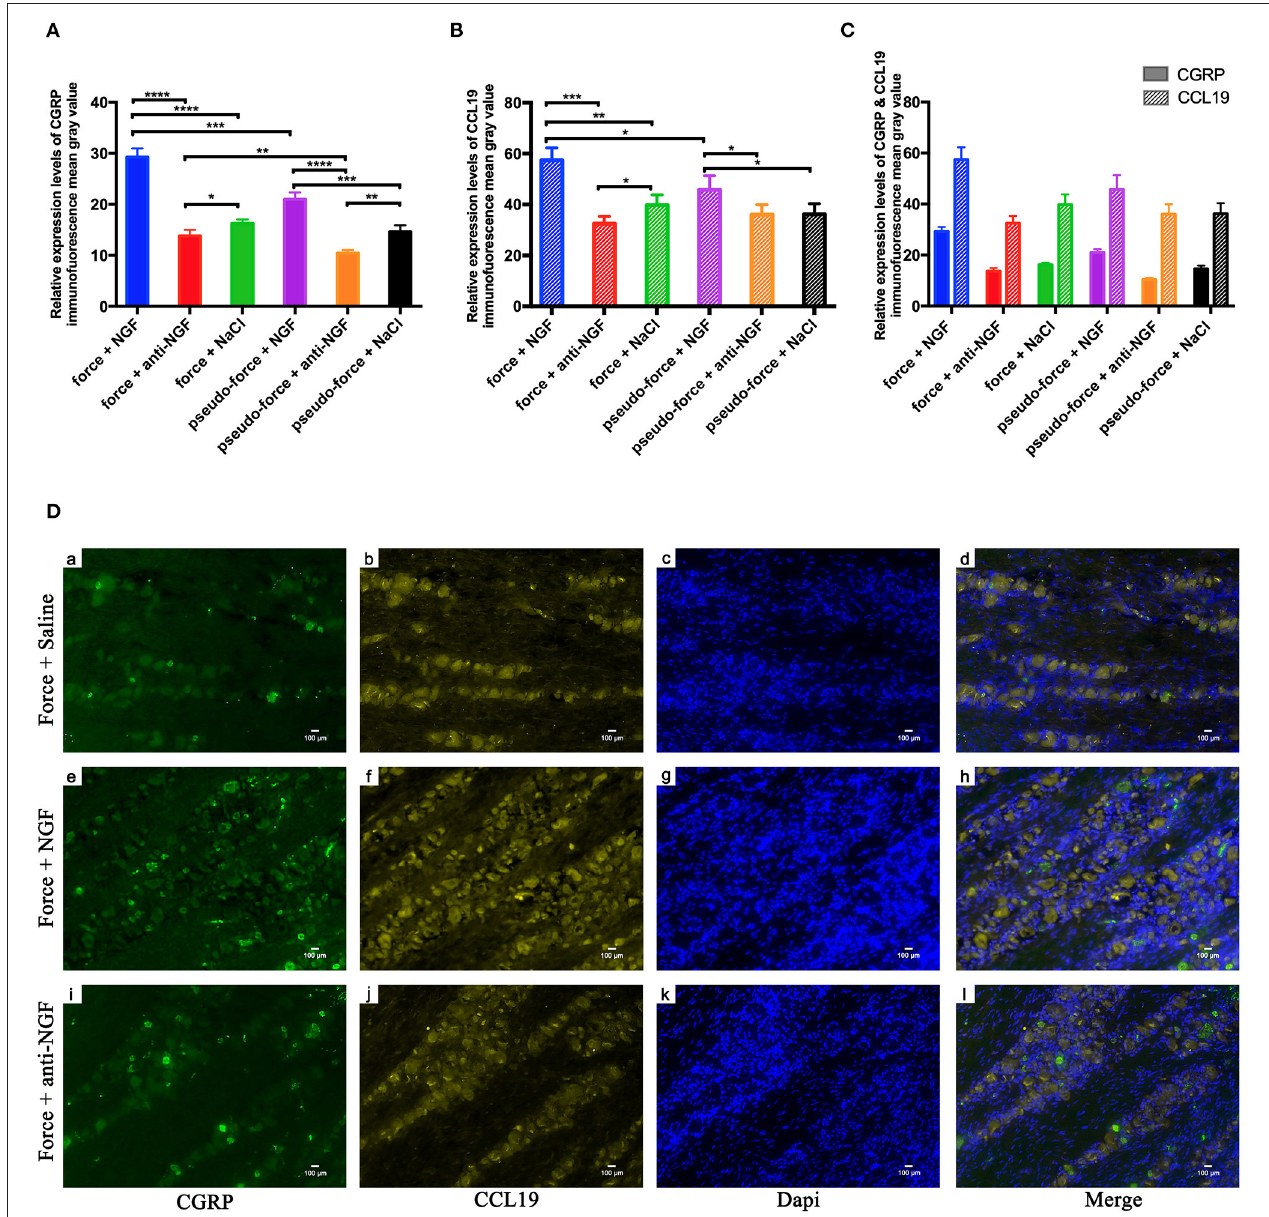
FIGURE 3 | ( A ) Calcitonin gene-related peptide (CGRP) protein expression levels in TGs following different interventions after experimental tooth movement. ( B ) CCL19 protein expression levels in TGs following different interventions after experimental tooth movement. ( C ) Comparison of immunofluorescence mean gray value of CGRP and CCL19 relative expression. ( D ) Immunofluorescence results of protein expression after injection on NGF, anti-NGF antibody, and normal saline into forced rats’ TGs on the 3rd day after tooth movement. ( a, e, i ) Neurons expressing CGRP (green) after injection of related reagents. ( b, f, j ) Neurons expressing CCL19 (yellow). ( c, g, k ) Nuclei (blue) after injection of related reagents on day 3. ( d, h, l ) Overlap of ( a + b + c ), ( e + f + g ), and ( i + j + k ). * p < 0.05, ** p < 0.01, *** p < 0.001, **** p <